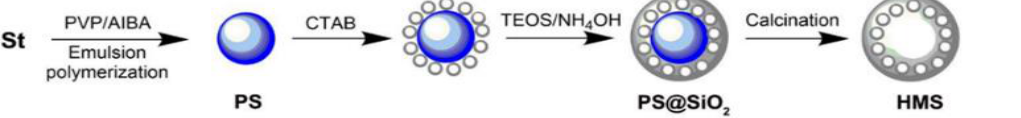
Figure 17. SEM images of hollow silica at pH 10 at different TEOS concentrations: ( A ) 0.06 M, ( B ) 0.12 M, ( C ) 0.24 M. ( D ) TEM of hollow silica spheres achieved at a TEOS concentration = 0.12 M [61]. The introduction of surfactants will also alter the surface charge, which can have an adverse or positive effect. H. Blas et al. [79] used positively and negatively charged PS with CTAB in both aqueous and non-aqueous solutions to study the effect of the surface charge on the coating. In the study, when an aqueous solution with no ethanol was used to coat PS, monodispersed hollow silica spheres with a similar morphology were success- fully synthesised with both surface charges. In the work, KPS was used as the initiator and dihexylsulphosuccinate sodium salt as a surfactant for the negatively charged PS